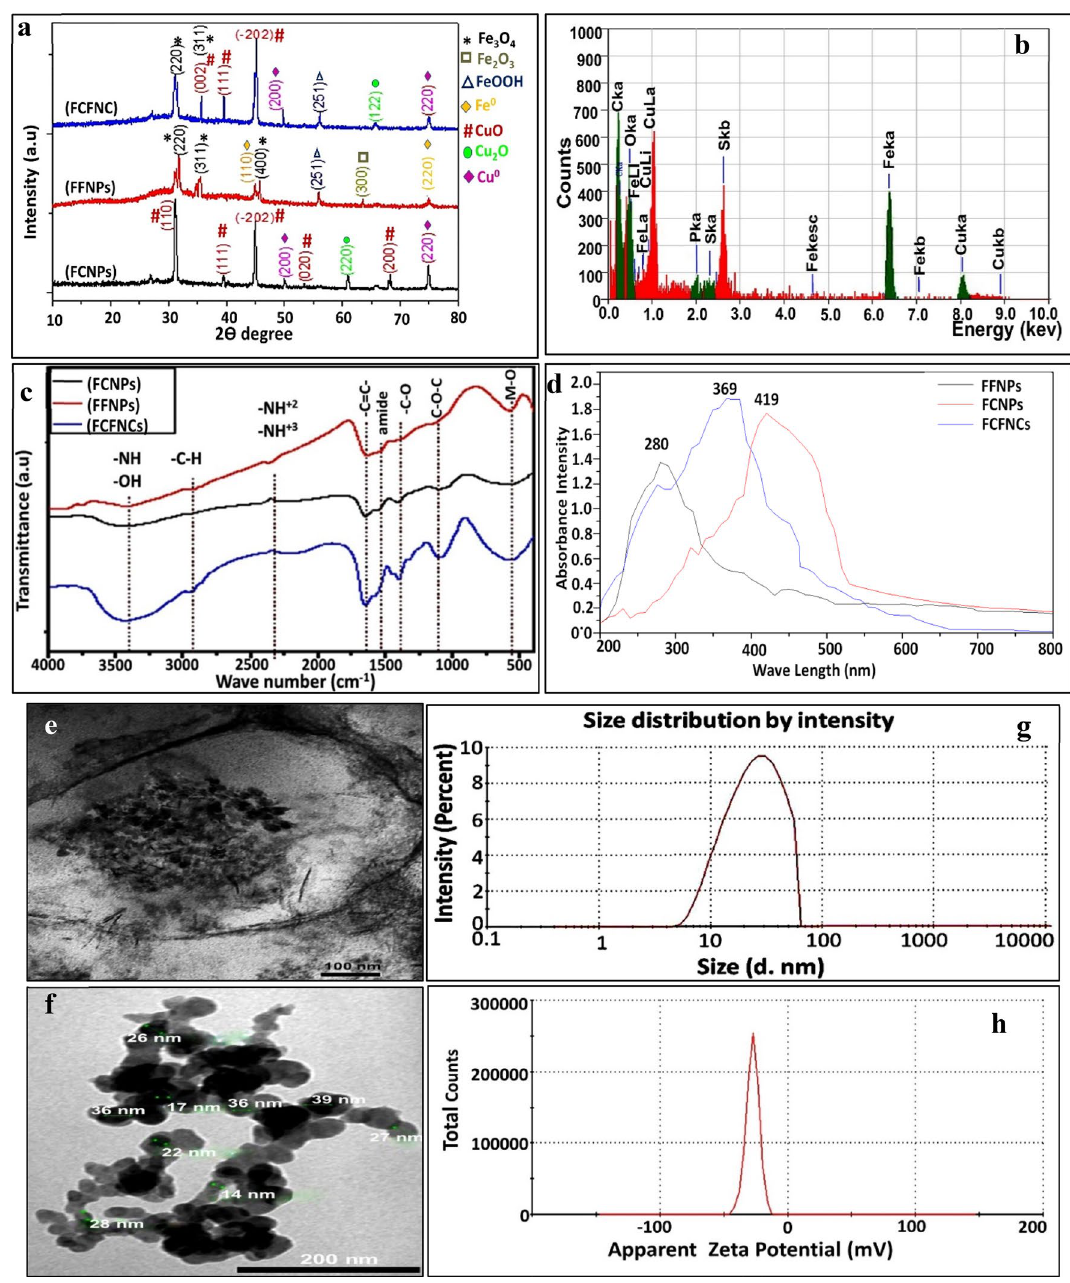
Figure 1. Characteristic features of the biosynthesized FCFNCs; XRD ( a ), EDX ( b ), FTIR ( c ), UV–Vis ( d ), TEM micrograph of cytoplasmic-localized FCFNCs synthesized by S. cyaneofuscatus EM3 during stationary phase ( e ), after extraction ( f ), Particle size distribution curve ( g ) and Zeta potential ( h tion planes were matched with values of the monoclinic cubic phase of CuO (JCPDS file no. 00-005-0661) 24,25 . The peak at 2θ = 60.95° (220) indexed cubic structure of Cu 2 O-NPs (JCPDS file no. 00-005-0667) as highlighted by Zhao et al. 26 . In addition, the presence of diffraction peaks at 49.9° and 74.89° matched reflection from (200) and (220) planes of the pure face-centered cubic structure of Cu 0 (JCPDS file no. 00-004-0836) 24 . Obviously, the main phase was CuO with low amounts of Cu 2 O phase in the examined sample of FCNPs. Notably, the oxidation states of Cu in the examined sample, including (0), (+ 1), and (+ 2), were very typical. The position of these peaks matched well the reports by Zhao et al. 26 and Karimzadeh et al. 27 , suggesting that Cu/Cu 2 O/CuO composites were successfully synthesized in the same sample. On the other hand, the crystalline structure of the as-prepared FFNPs exhibited Fe 0 /FeOOH/Fe 2 O 3 /Fe 3 O 4 as shown in Fig. 1a. The formed hexagonal Fe 2 O 3 and cubic Fe 3 O 4 nanostructures within the designed nanocom- posite were indexed by (JCPDS file no. 01-89-0596] and (JCPDS file no. 01-071-6336], respectively 28,29 . The peak at 35.61° might be a combination of Fe 2 O 3 and Fe 3 O 4 . The peak at 45.02° and 74.8° matched the reflection from